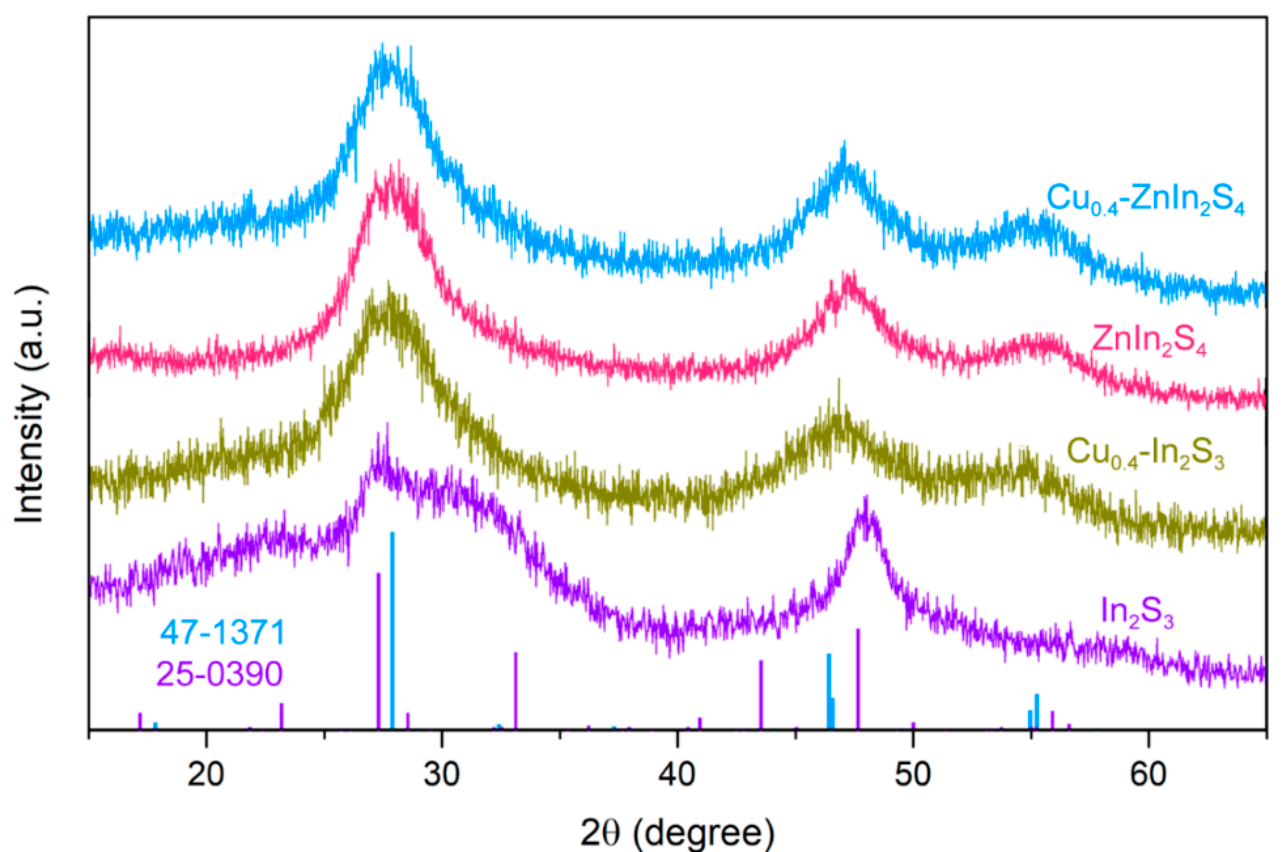
Figure 1. The XRD patterns of In 2 S 3 , Cu 0.4 -In 2 S 3 , ZnIn 2 S 4 and Cu 0.4 -ZnIn 2 S 4 QDs. The size and morphology of the synthesized various QDs were also investigated. According to Debye–Scherrer formula, the broad diffraction peaks implied the ultra-small size of the nanocrystals in three dimensions [30,31]. While the similar full width at half maximum (FWHM) of different contents of Zn and/or Cu decorated In 2 S 3 QDs indicated